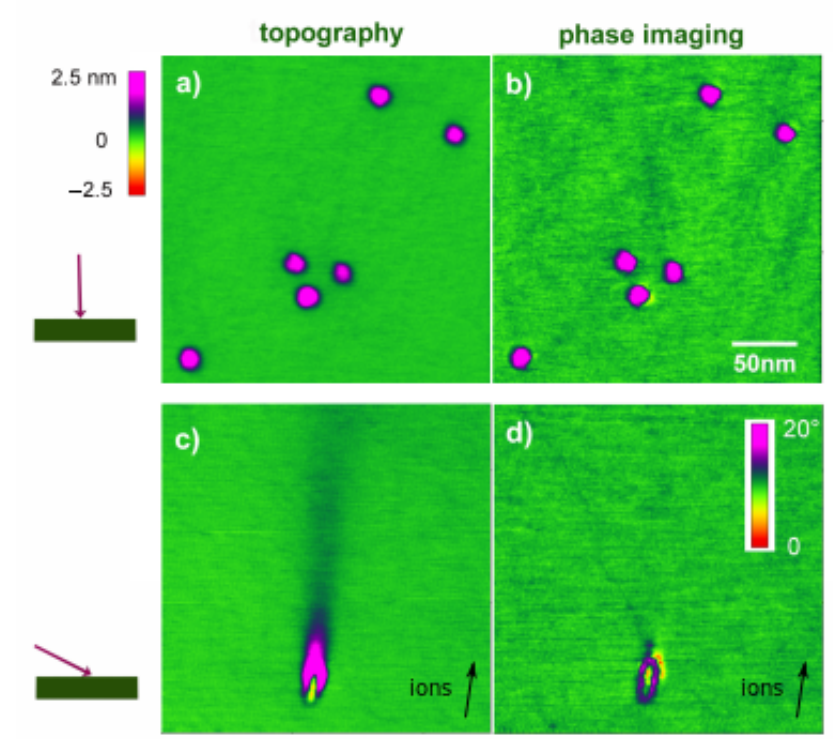
Figure 2. Topographic ( a , c ) and phase ( b , d ) SFM images of individual ion tracks produced by 3 MeV/u Au 51 + ions on freshly-cleaved mica surfaces. The scale bar of 50 nm applies to all images. The color scale covers variations of height of ± 2.5 nm relative to the unmodified surface in the topographic channels and phase shifts of 20 ◦ in the phase images. Black arrows indicate the direction of the ion beam for grazing